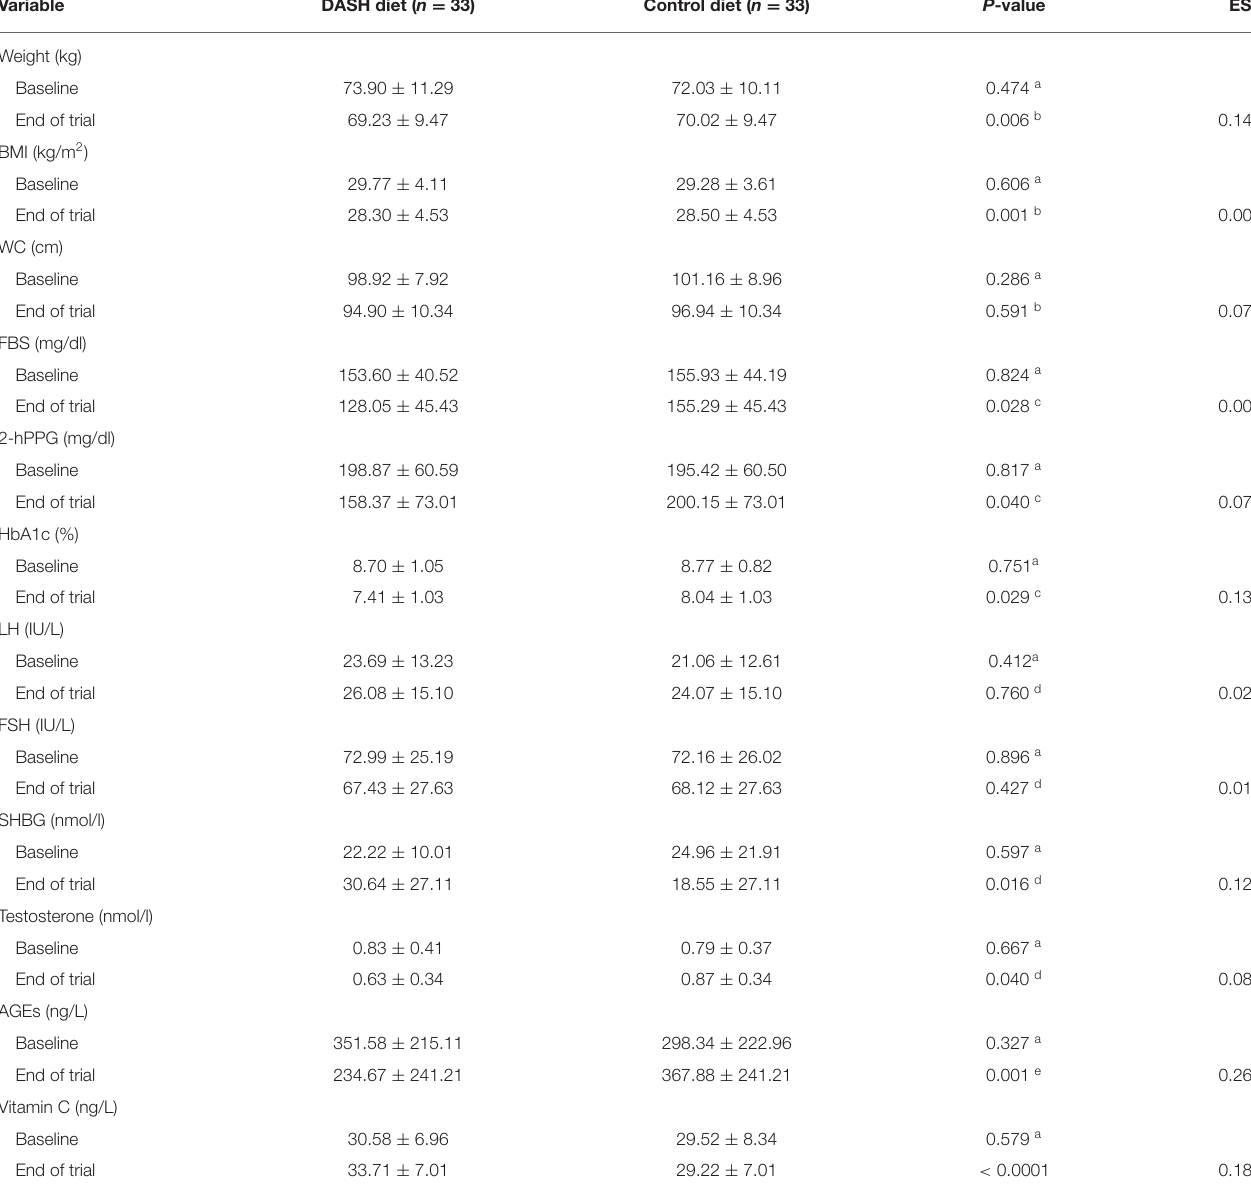
TABLE 4 | Anthropometric indices and biochemical tests at baseline and after 12 weeks of intervention in postmenopausal diabetic patients. Variable DASH diet ( n = 33) Control diet ( n = 33)